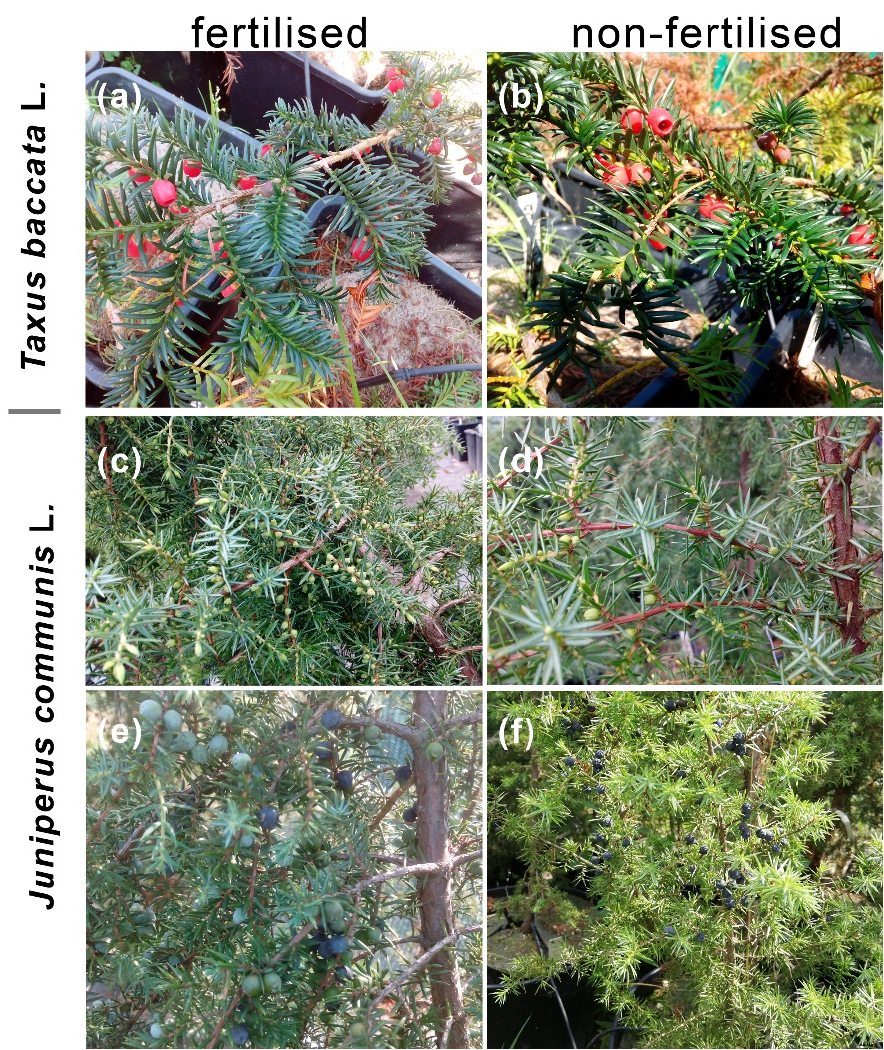
Figure 1. Features of Taxus baccata L. ( a , b ) and Juniperus communis L. ( c–f ) plants grown in fertilised ( a , c , e ) and non ‐ fertilised conditions ( b , d , f ) within the observation